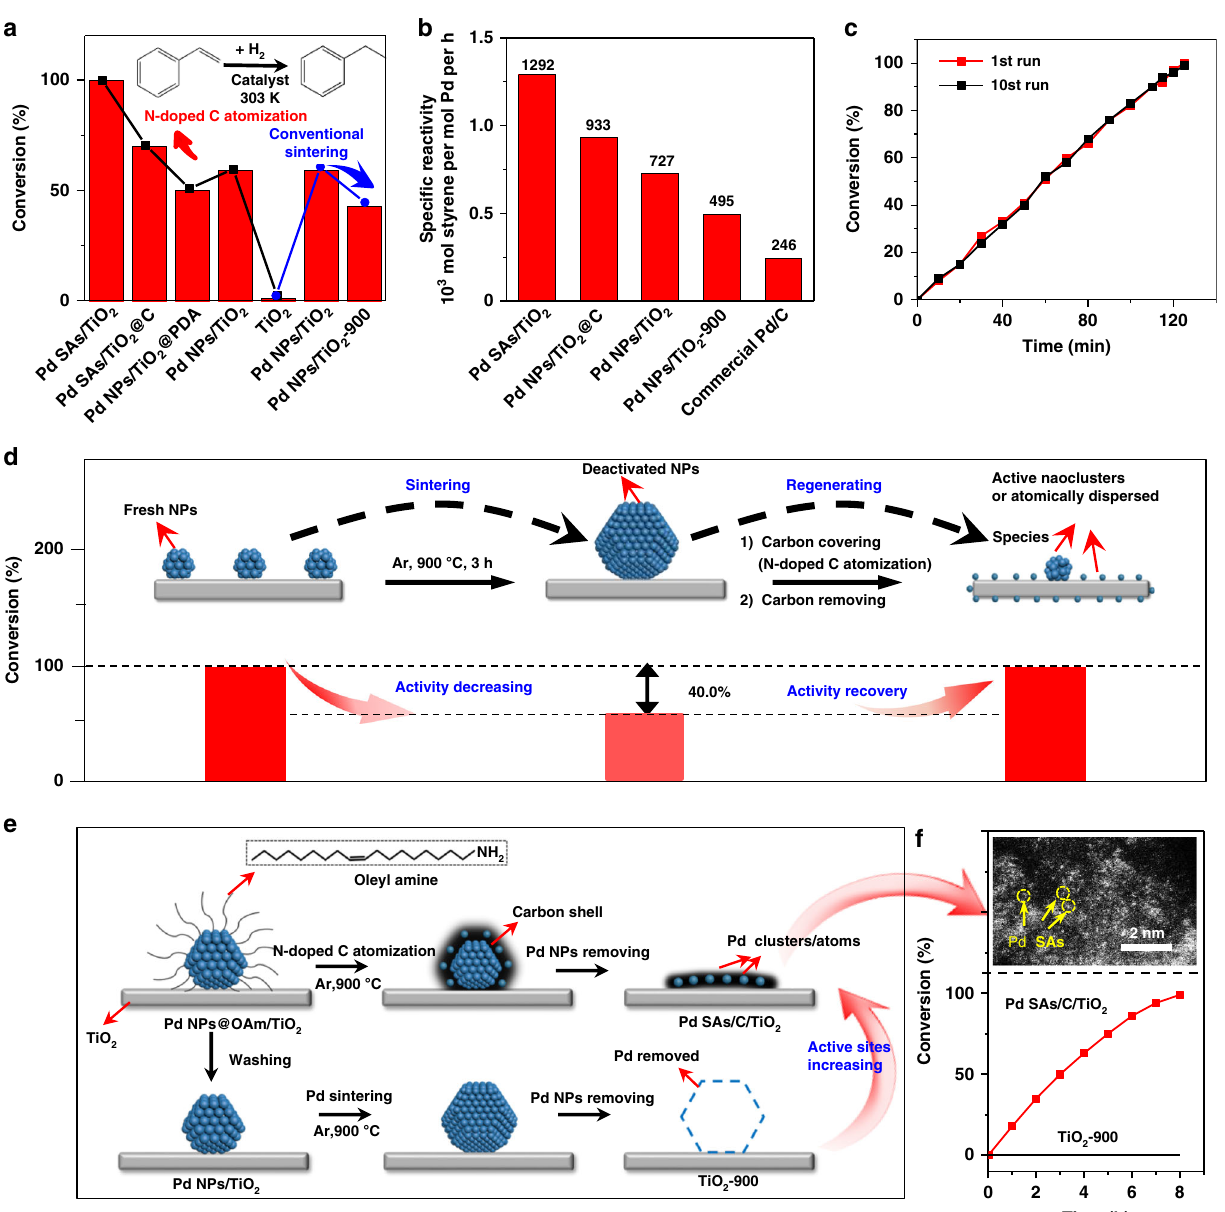
Fig. 4 Catalytic performances and schematic illustrations of Pd SAs and Pd NPs. a Catalytic performance for fresh TiO 2 and catalysts prepared by N- doped C atomization and conventional sintering in styrene hydrogenation. b Speci fi c reactivity of Pd SAs/TiO 2 and the reference catalysts. c Catalytic stability of Pd SAs/TiO 2 . d Schematic images (top) of the formation of deactivated NPs and active nanoclusters or atomic species. Catalytic performance (bottom) of Pd NPs/TiO 2 , Pd NPs/TiO 2 -900 and Pd NPs/TiO 2 -900 after treatment by N-doped C atomization process (denoted as Pd SAs/NPs/TiO 2 - 900) in styrene hydrogenation for 3.5 h. e Schematic images of the formation of Pd SAs/C/TiO 2 by N-doped C atomization process (by using Pd NPs@OAm/TiO 2 as precursors) and TiO 2 -900 by conventional sintering (by using Pd NPs/TiO 2 as precursors). f AC HAADF-STEM image of Pd SAs/C/ TiO 2 and its catalytic performance. Scale bar, 2